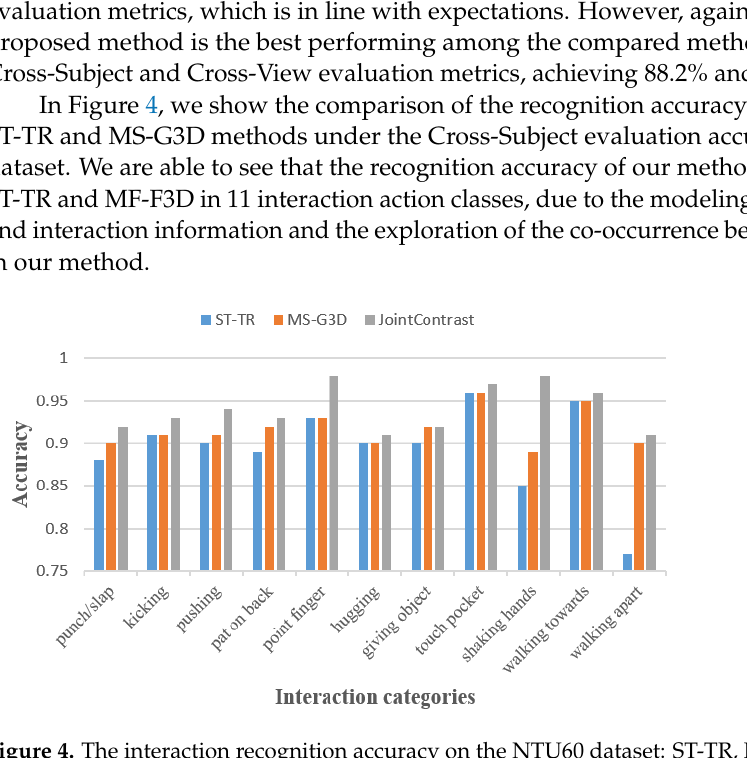
Figure 4. The interaction recognition accuracy on the NTU60 dataset: ST-TR, MS-G3D and our Joint-